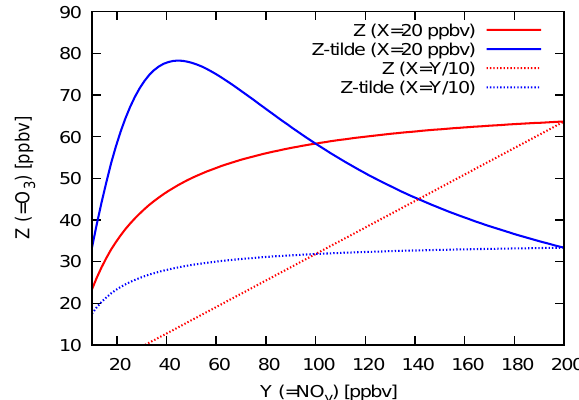
Fig. 3. Equilibrium concentrations for Z (red line) and ˜ Z (blue line) [ppbv] as a function of the concentration of Y for a constant con- centration of X=20ppbv (solid) and a constant ratio between the concentration of species X and Y of 1:10.